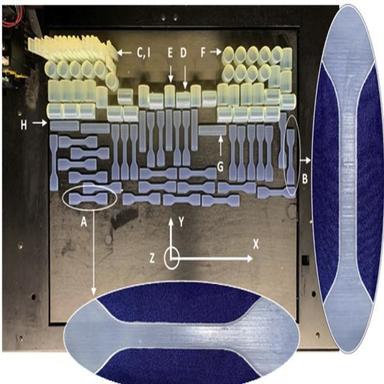
Stratasys Connex3 Objet500 printer bed with printed X- Y- and Z- tension (A, B and C respectively), compression (D, E and F) and DMA (G, H and I) samples. Streaks left by the PolyJet printing process can be seen lengthwise along the X-tensile sample (A) and along the width of the Y- sample (B).